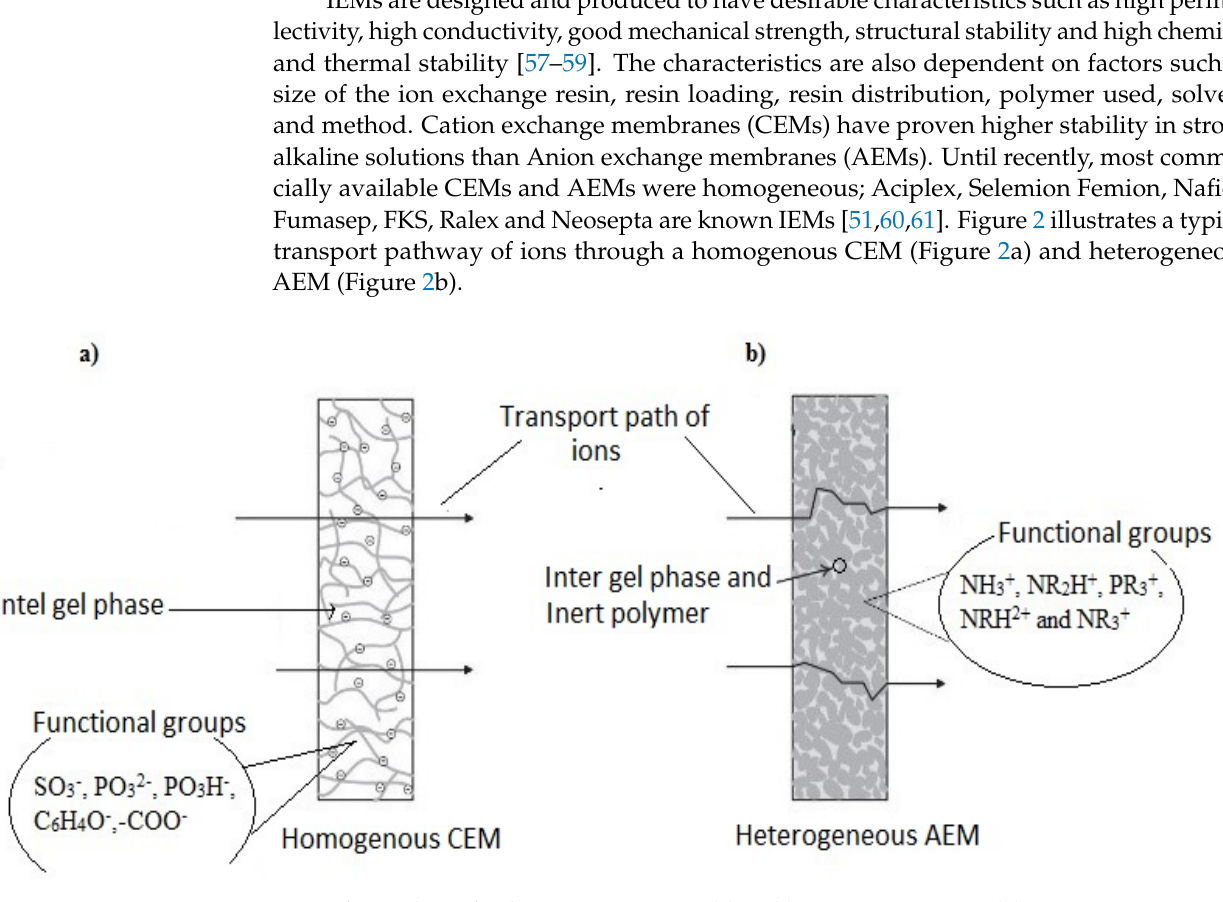
Figure 2. Ions pathway through a homogeneous CEM ( a ) and heterogeneous AEM ( b )